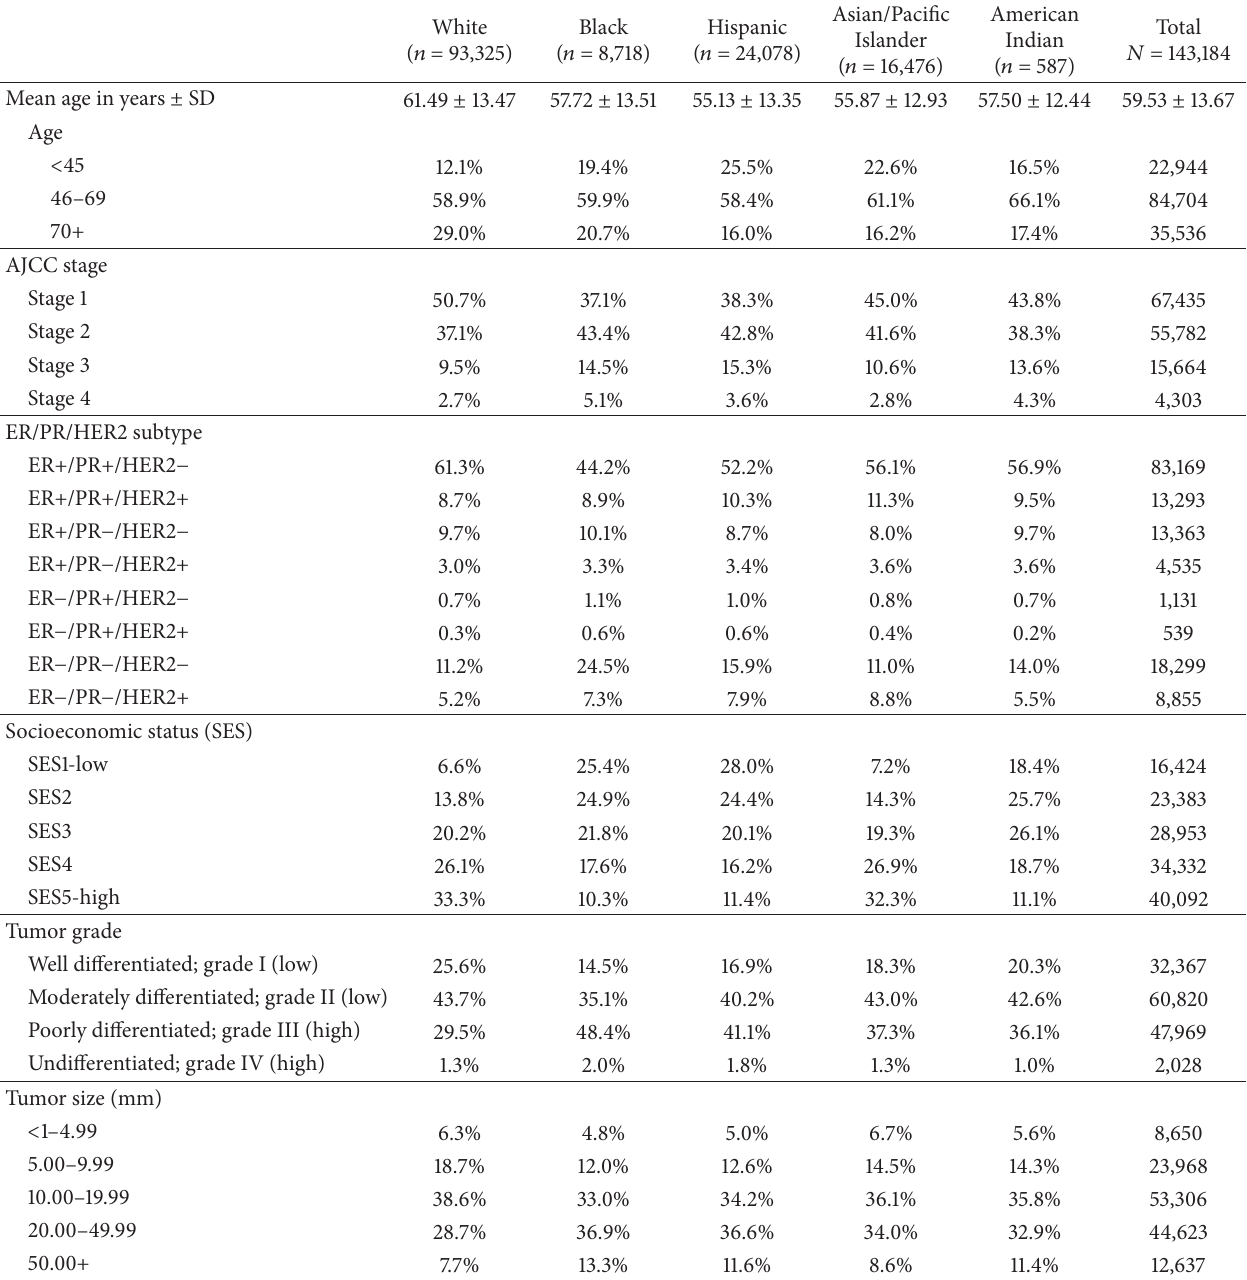
Table 1: Demographic and clinicopathologic characteristics of 143,184 AJCC stages 1–4 of first primary female invasive breast cancer from the California Cancer Registry 2000–2012 ∗